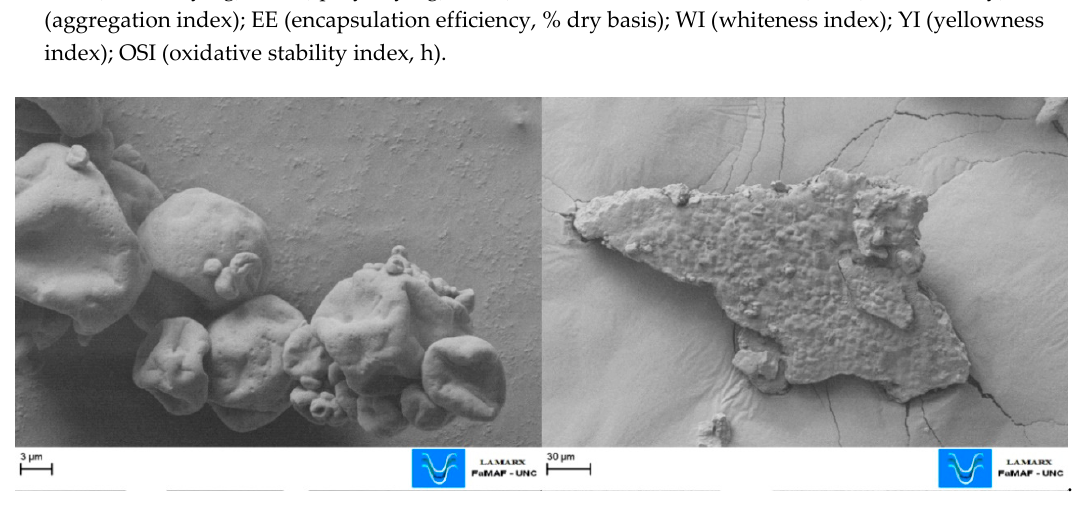
Figure 2. Scanning electron microscopy (SEM) images for microencapsulated CSO. ( Left ) spray drying; ( Right ) freeze